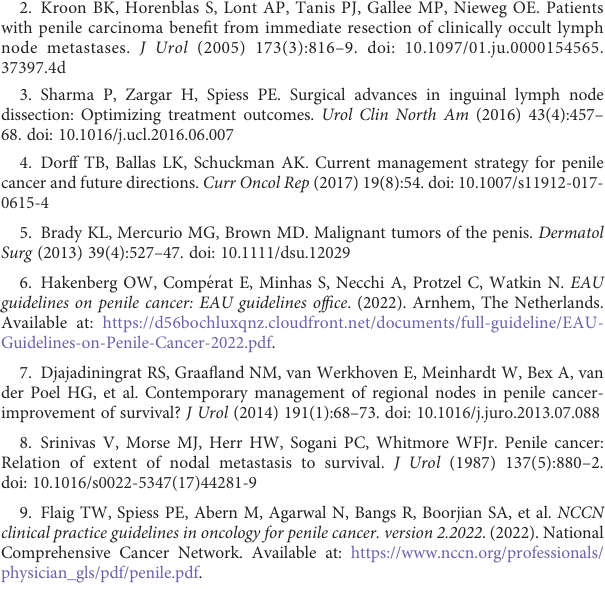
SUPPLEMENTARY FIGURE 1 SMD values of the baseline information for the primary and adjusted cohorts. SUPPLEMENTARY FIGURE 2 Time-dependent ROC curves based on the timing of surgery in the delayed